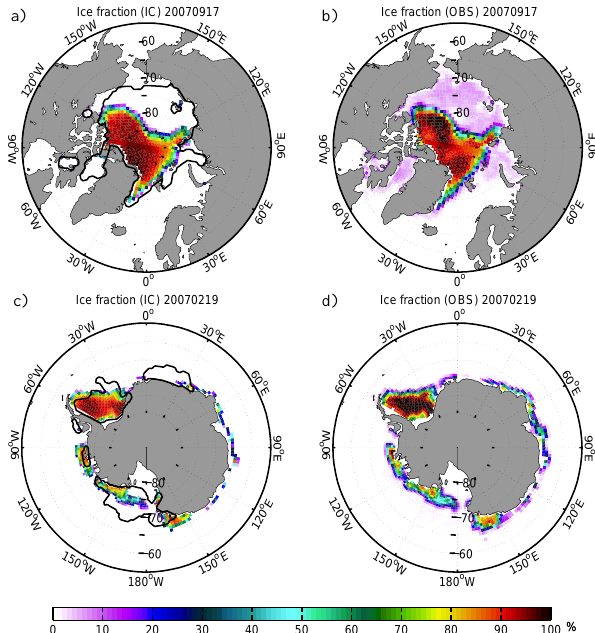
Fig. 4. Sea-ice concentrations during the minimum of sea-ice extent in 2007 in the NH (a, b) and SH (c, d) . Colors show the sea-ice con- centration in IC simulation (a, c) and in the OBS (b, d) . The thick black line represents the sea-ice extent in the FREE simulation.